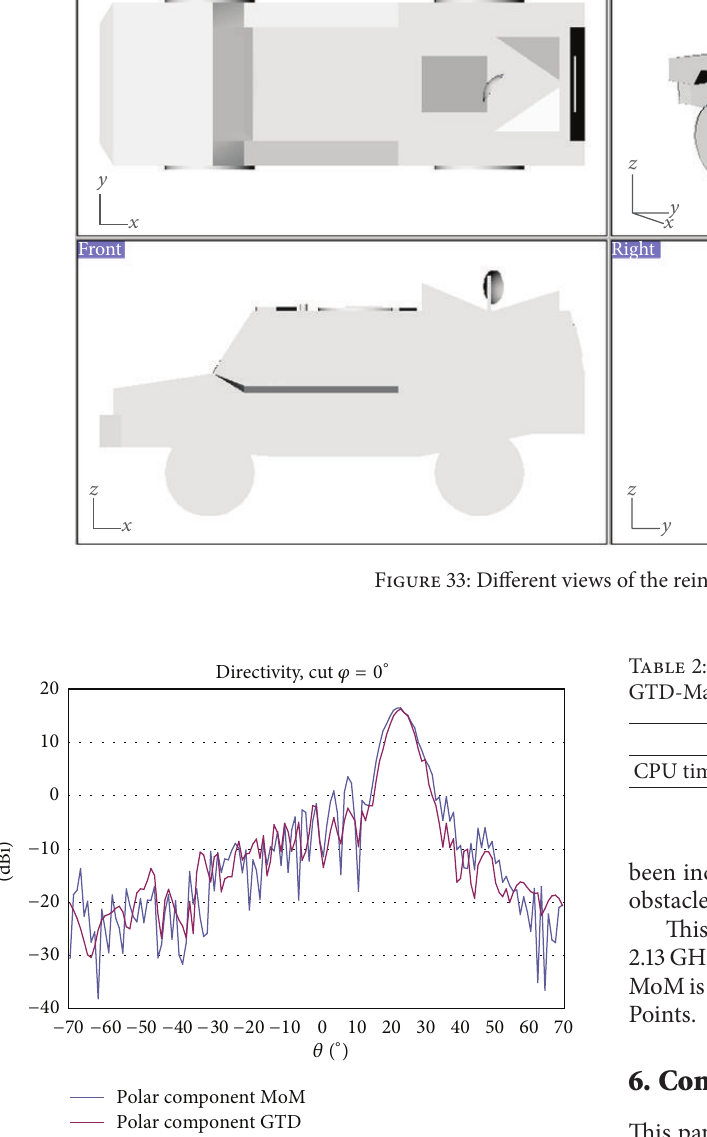
Figure 34: Polar component obtained with GTD and MoM, cut in 𝜑 = 0 ∘ .